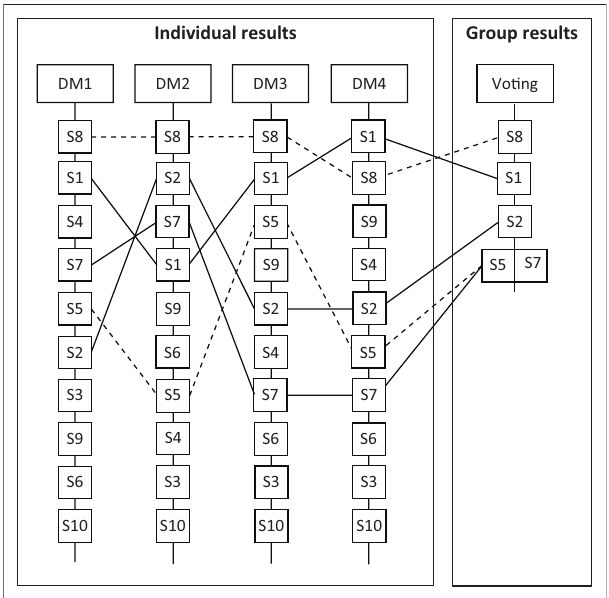
FIGURE 3: Comparison of individual and group